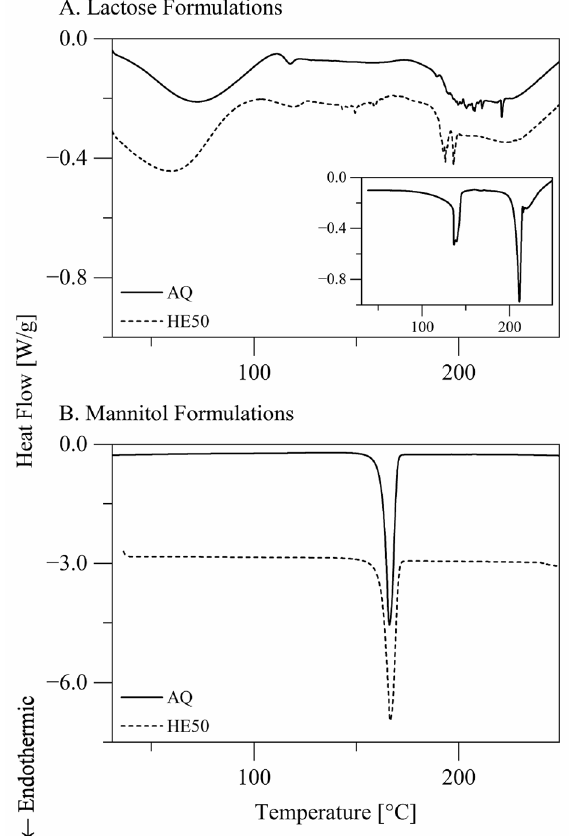
Figure 3. Differential scanning calorimetry thermograms of nano spray-dried ( A ) lactose and ( B ) mannitol powder materials. Presented data are for materials prepared by spray drying of aqueous (AQ) or hydroethanolic (HE50) solutions with a solute concentration of 3.00% w / w at an inlet temperature of 80 °C. Spray-dried lactose materials were amorphous. The insert of panel A presents data of crystalline α -lactose monohydrate material for comparison. Spray-dried mannitol materials were in the α / β crystalline form.